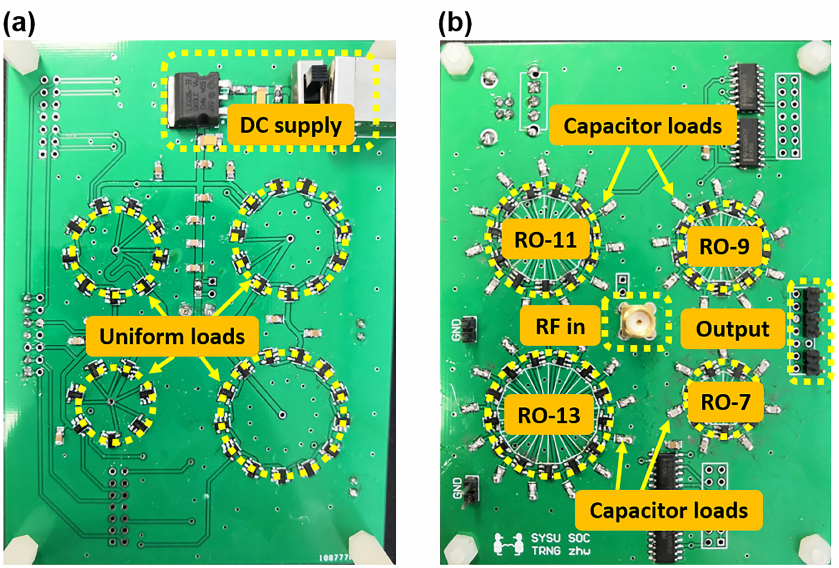
Figure 14. RO array at the PCB level. ( a ) PCB bottom layer; ( b ) PCB top layer.